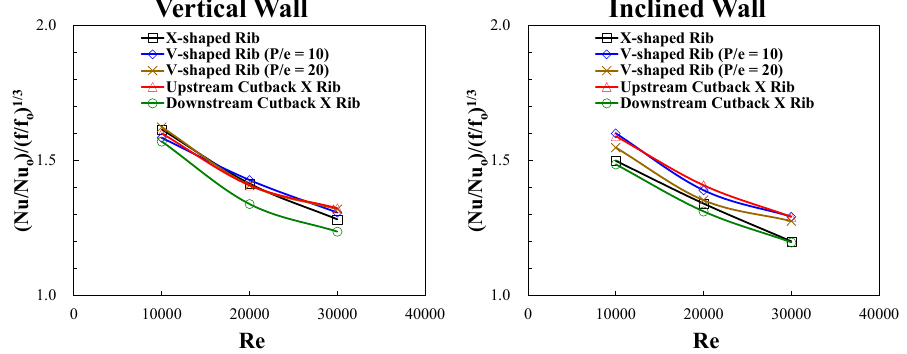
Figure 12. Thermal performance.